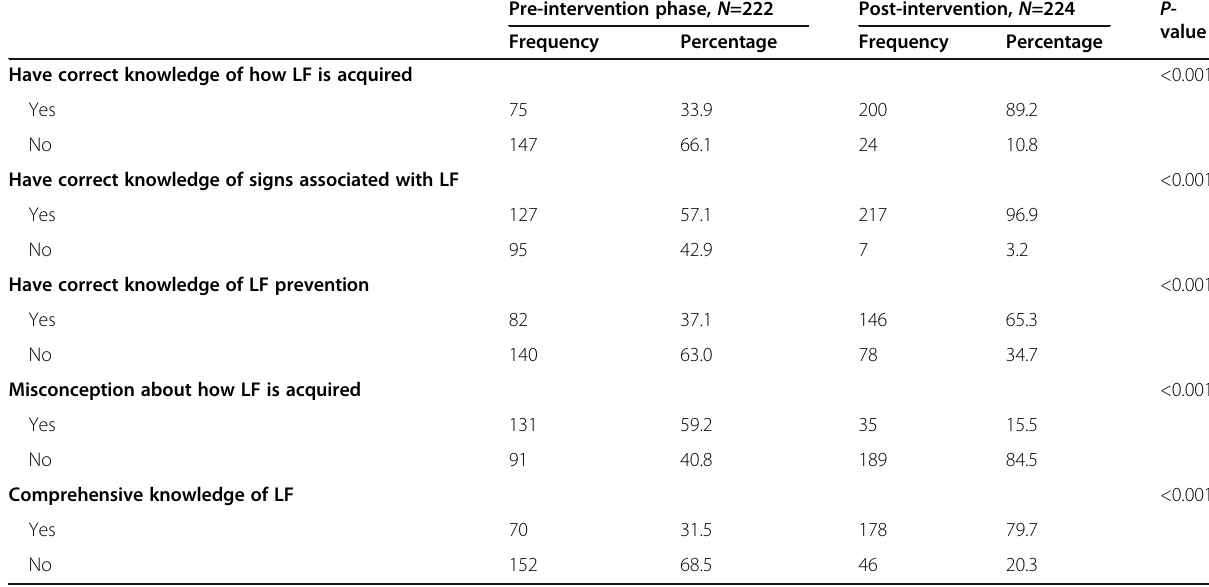
Table 3 Knowledge about lymphatic filariasis before and after intervention among community members in Bole District Pre-intervention phase, N